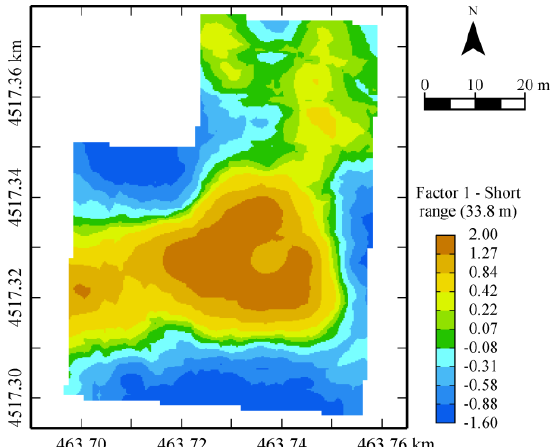
Figure 7. Map of the 33.8-scale factor of soil properties.